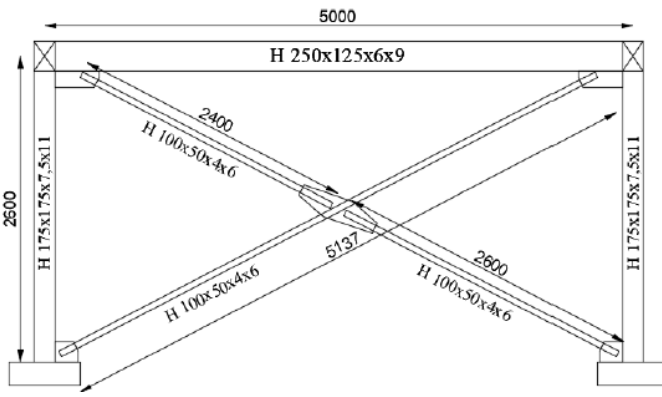
Figure 5. Experimental loading protocol of Wakabayashi’s test.